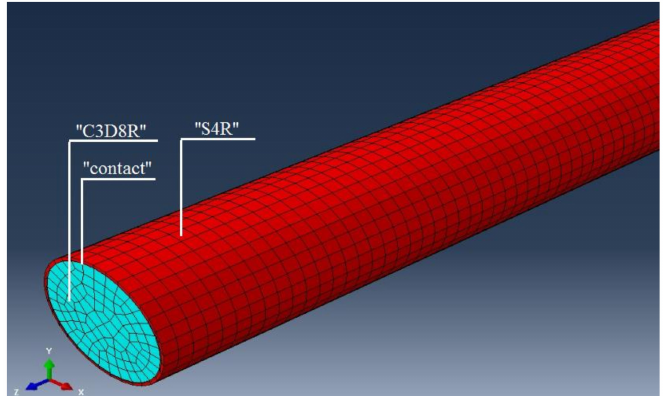
Figure 7. Three-dimenional model of CFT column in ABAQUS.